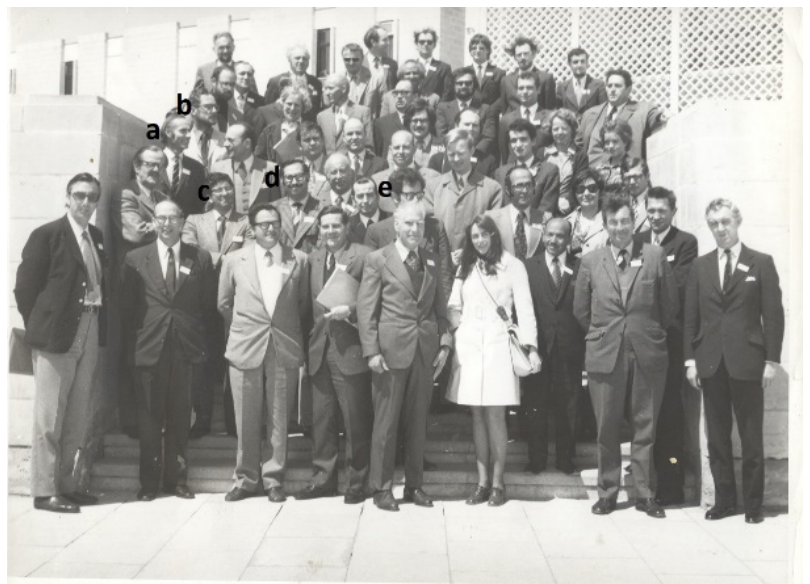
Figure 2. The Malta participants 1973. ( a ) Chris P; ( b ) Job Kuijt; ( c ) Jose Cubero ( d ) Abed Saghir; ( e ) Lytton M.